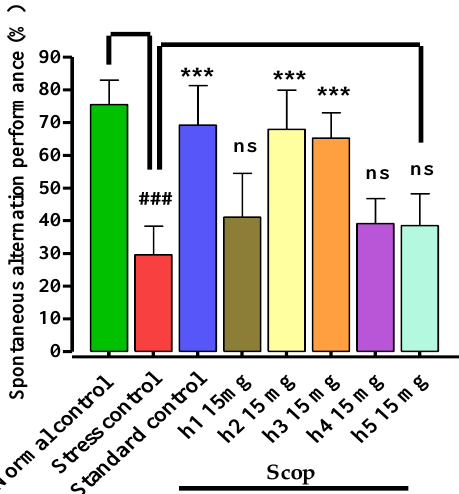
Figure 4. Effects of mono-carbonyl curcumin analogues ( h1 – h5 ) on percent spontaneous alterna-